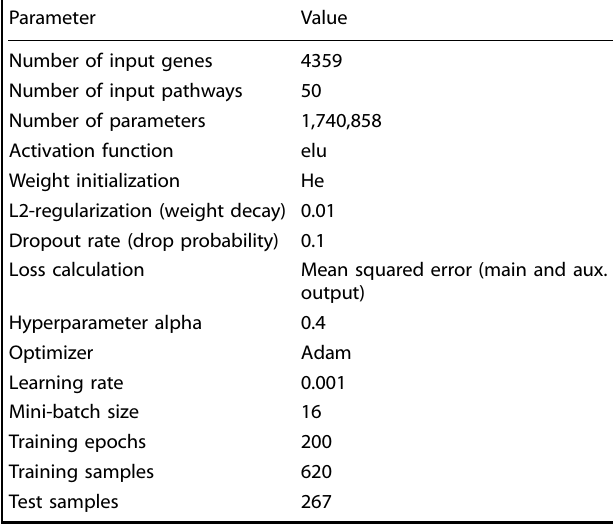
Table 1. Pathway-based neural network